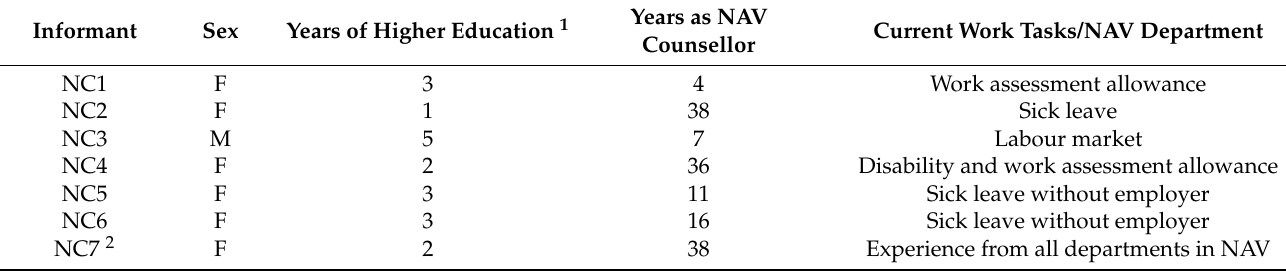
Table 2. NAV counsellors’ characteristics [22]. Copyright 2021, with permission from Springer Nature.